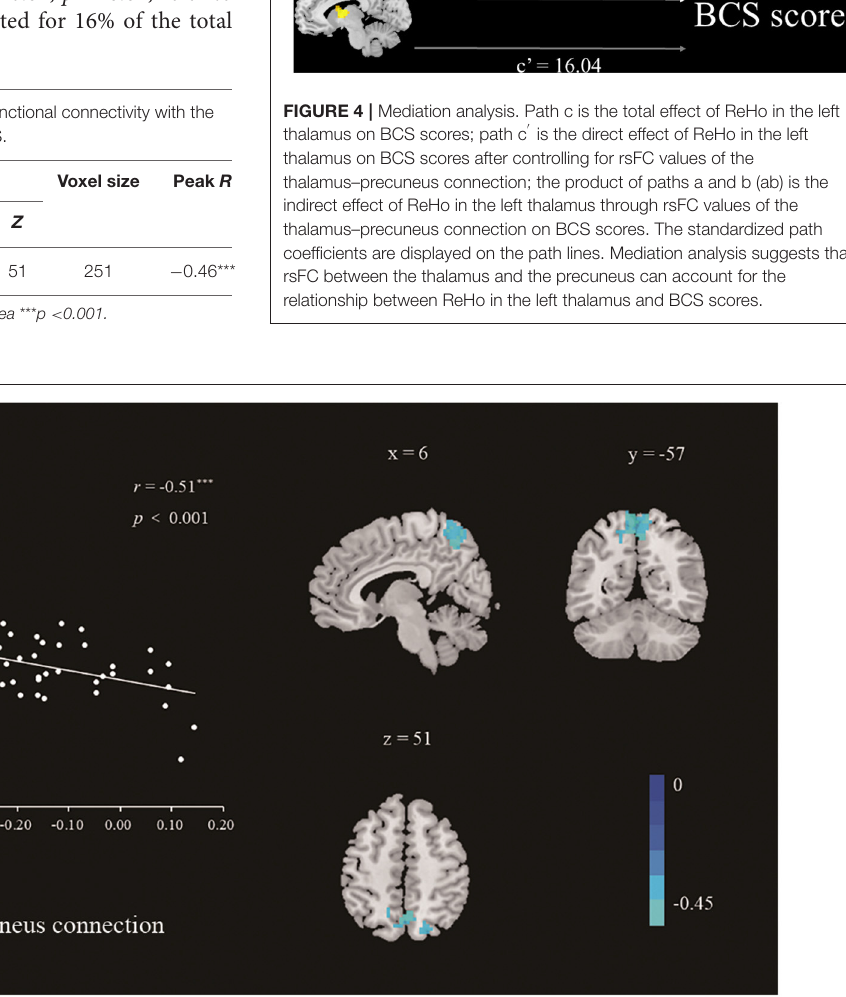
Frontiers in Psychology |